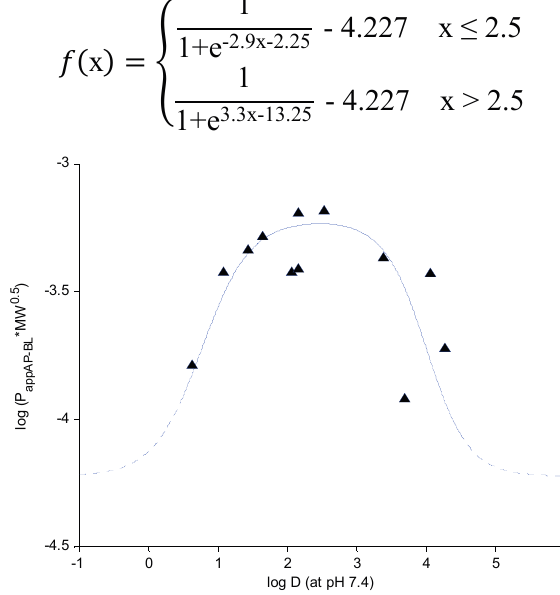
Figure 6. The relationship between permeability log ( P app AP-BL *MW 0.5 ) and log D (at pH 7.4) of twelve